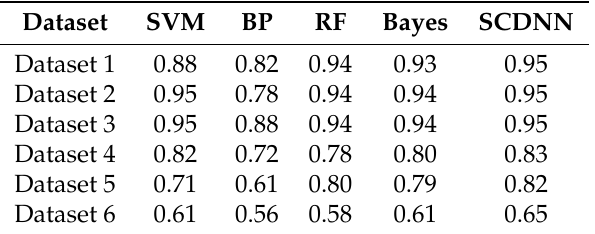
Table 6. Area under curve (AUC) values for the ROCs of each model in the six datasets.